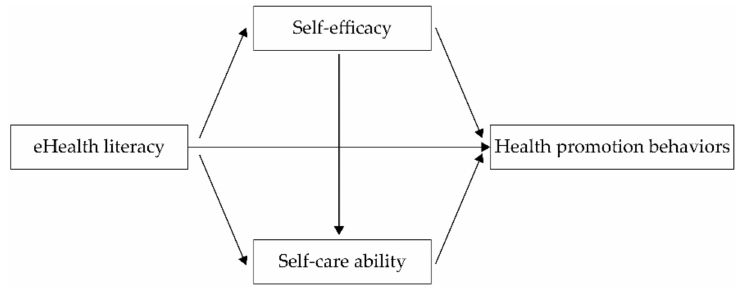
Figure 1. The conceptual